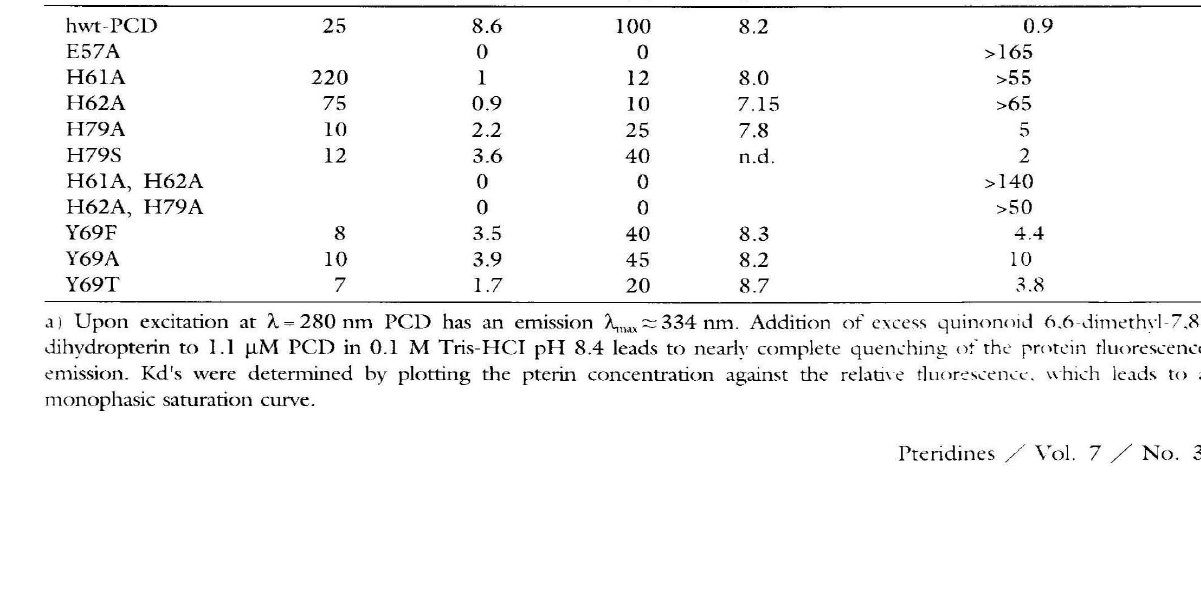
Table 1. Catalytic prooperties of hwt-PCD and selected mutants and binding of quinonoid 6,6-dimethyl-7,8-dihy _iropterin to PCD. Kinetic constants were calculated from the dehydration rates of 6-methyl-pterin-4a-carbinolamine :()llowed at 245 nm in 10 mM Tris-HCI pH 8.5 at 10°C . Enzyme catalyzed assays have been corrected for the spon ,aneous decay. pK values were estimated from plots of the activity at varying pH and in the presence of a constant elec trolyte concentration of 0.1 M KCI. Vnm is expressed as the turnover number, i. e., nmol of substrate dehydrated per :<mol of enzyme subunit per seczond (adapted in part from [7]). Enzyme K,,, (I-LM